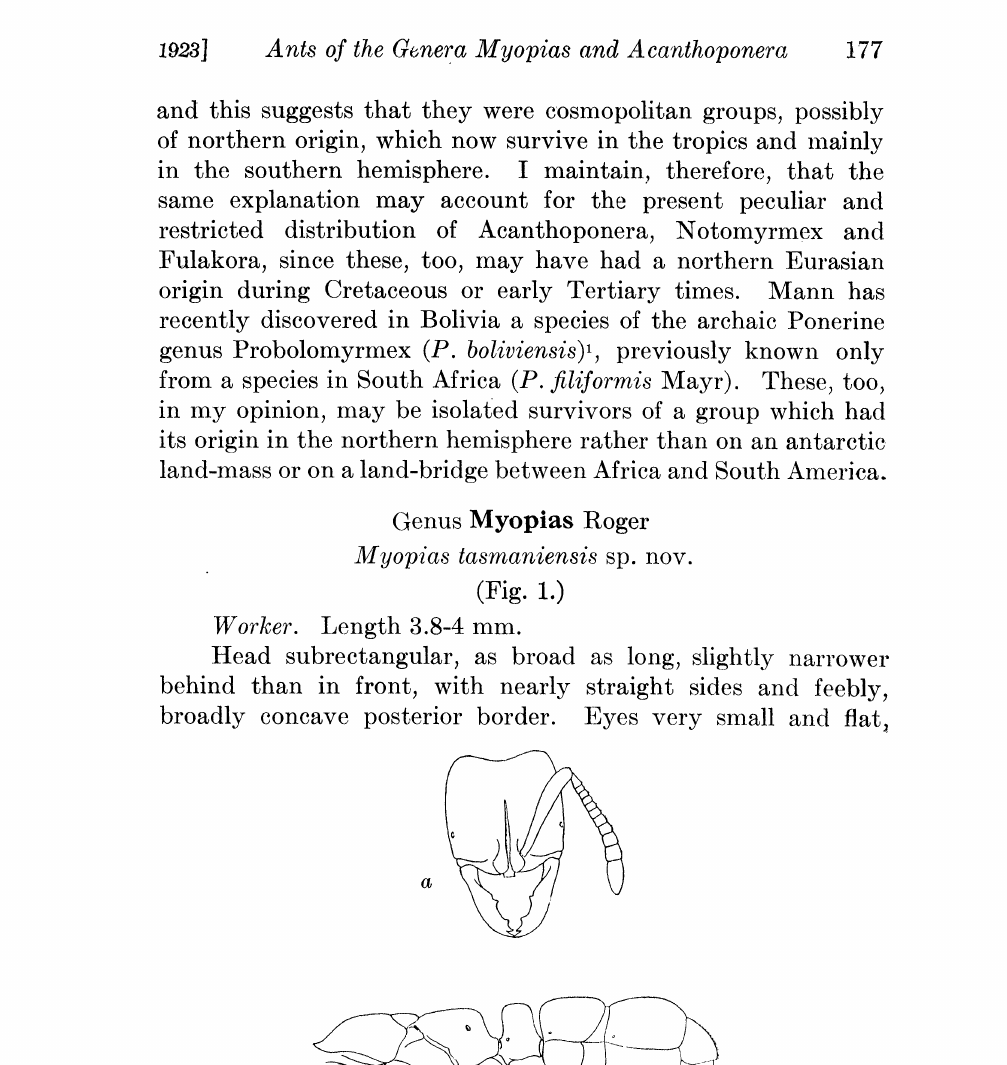
Fig. 1. Myopias tasmaniensis sp. nov. worker, a, head from above; b, thorax and ab- domen in profile. situated more than their own length from the posterior border of he clypeus, consisting of hardly more than 15 minute,